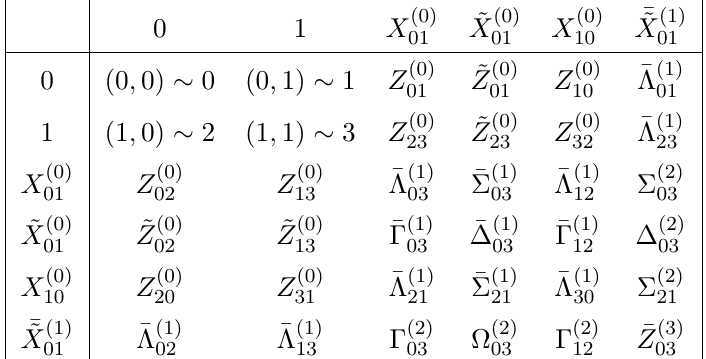
Figure 9 : a) Toric diagram and b) quiver for the conifold.